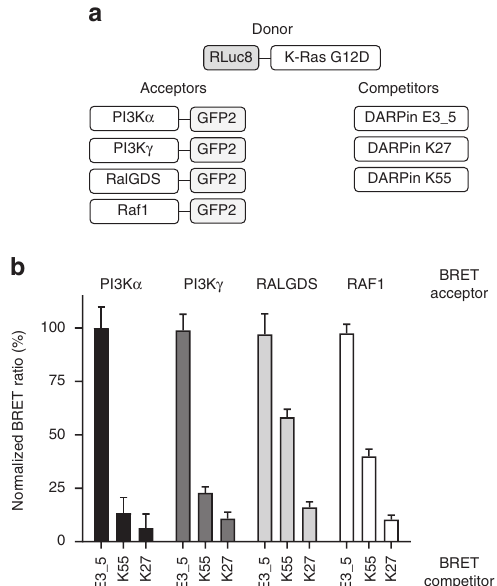
Figure 6 | Anti-Ras DARPins inhibit intracellular Ras interactions with downstream effector molecules. In an intracellular bioluminescent resonance energy transfer (BRET) assay, full-length K-Ras G12D-RLuc8 donor molecules were co-expressed with various Ras-binding or Ras-associated domains fused to GFP2 acceptors to trigger a BRET signal. ( a ) Diagrammatic format of donor, acceptor and competitor molecules. ( b ) Normalized BRET ratio (normalized to the negative control DARPin E3_5) generated in HEK293Tcells transfected with plasmids expressing the indicated BRET pairs in the presence of different DARPins as competitors. Error bars represent the mean ± s.d. ( n ¼